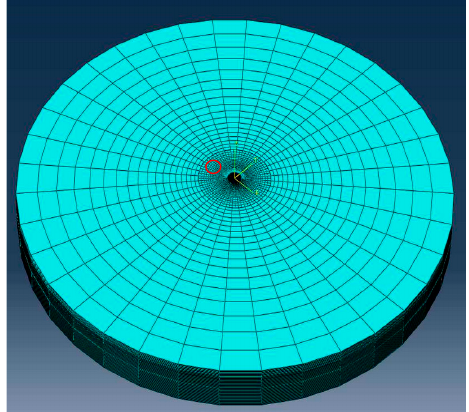
Figure 4. Finite element analysis model in ABAQUS software for calculating the calibration coeffi- cients in orthotropic materials, displaying local mesh refinement in the direct vicinity of the drilled hole (recompiled from [23]).